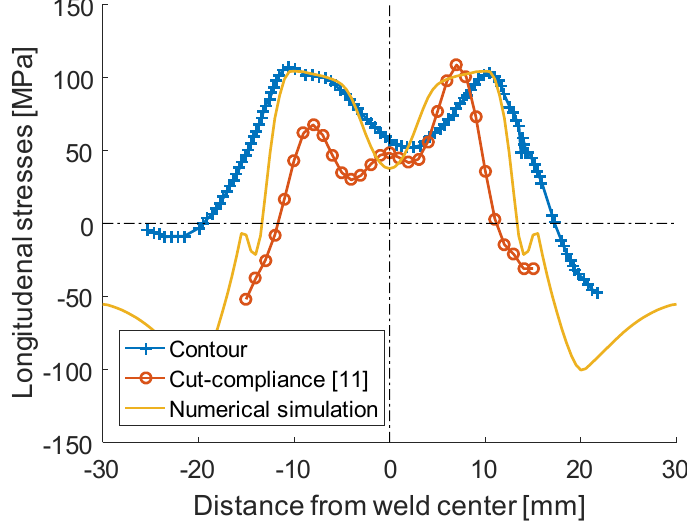
Figure 6. Comparison of the longitudinal residual stress profiles from the contour method and the numerical simulation, together with the stress profile obtained by Sonne et al. [9] via the cut-compliance method from an FSW experiment comparable with the experiment in the present work.